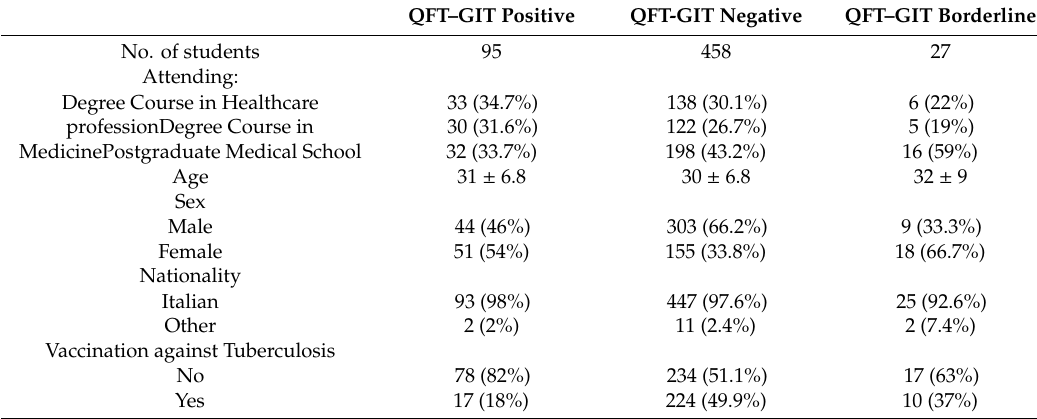
Table 2. Characteristics of the students stratified by the first QuantiFERON-TB ® Gold In-Tube assay (QFT–GIT) test